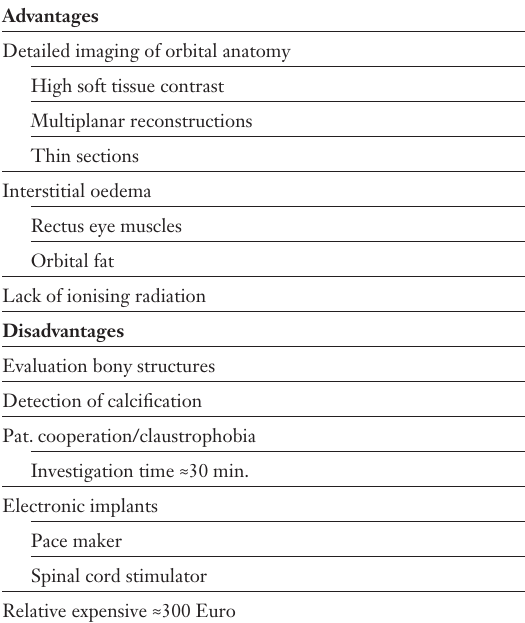
CoronalT2-wTIRM fat suppression sequences. a) Measurement of amount of oedema. Region Of Interest (ROI) set in the inferior rectus muscle and the temporalis muscle of each side, in the active stage of disease.The Signal Intensity Ratio (SIR) is expressed as a ratio of the signal intensities of the inflamed extra-ocular muscle to the (in GO never inflamed) temporalis muscle. b) Measurement of the cross sectional areas of the thickest muscle, both on the left and right orbit.